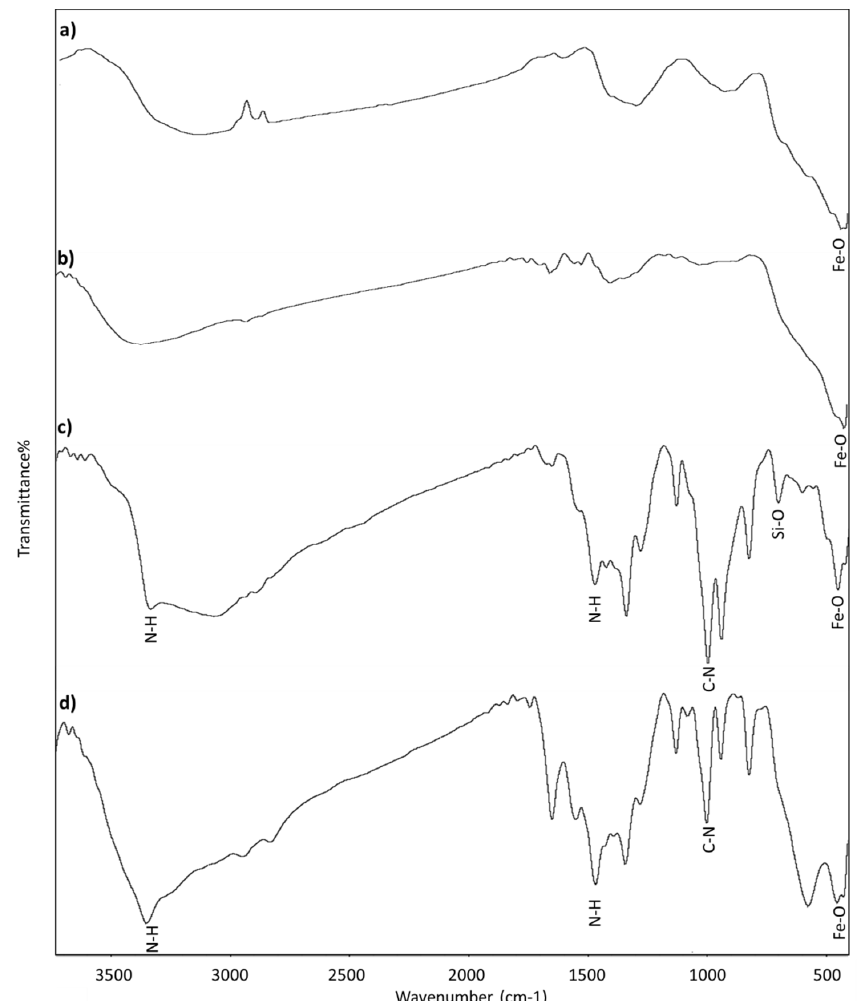
Figure 6. Fourier-transform infrared spectroscopy (FT–IR) of ( a ) synthesized Fe, ( b ) Ag/Fe, ( c ) APTES–Ag/Fe, and ( d )